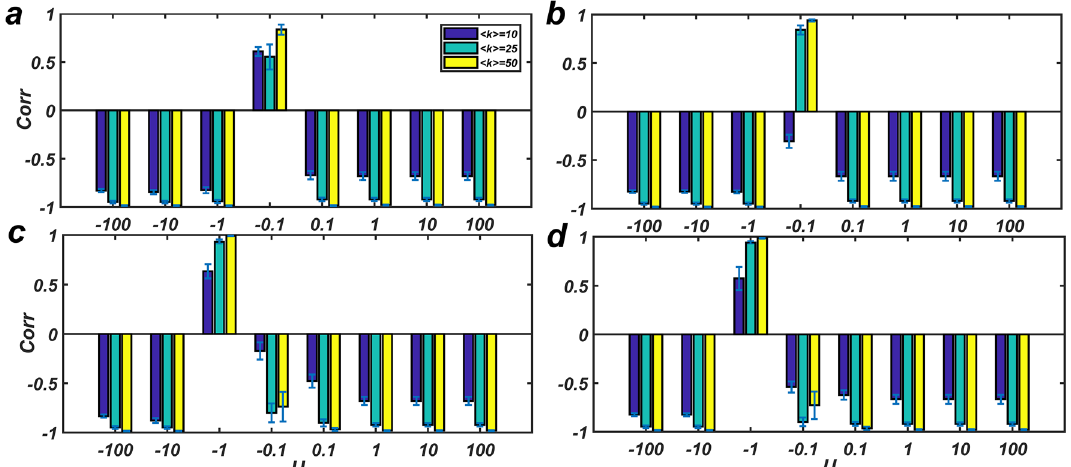
Figure 4. The correlation coefficient between two functions f and g when the input signal is applied to only drivers. Although the correlation is still negative, its absolute value is less compared to the case of applying the input signal to all nodes. Designations are as Fig. 3.